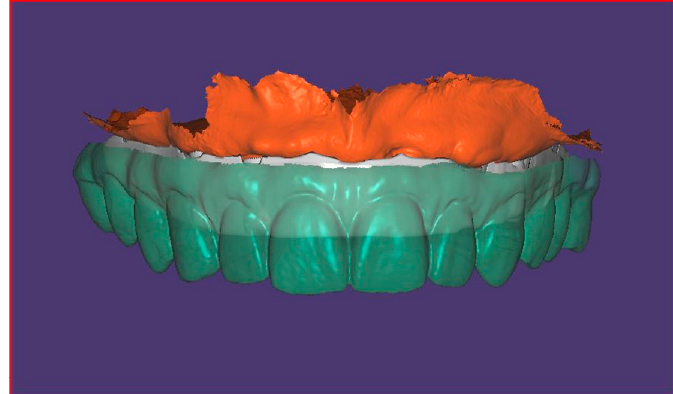
Figure 5. Virtual models of the framework and of the superstructure.